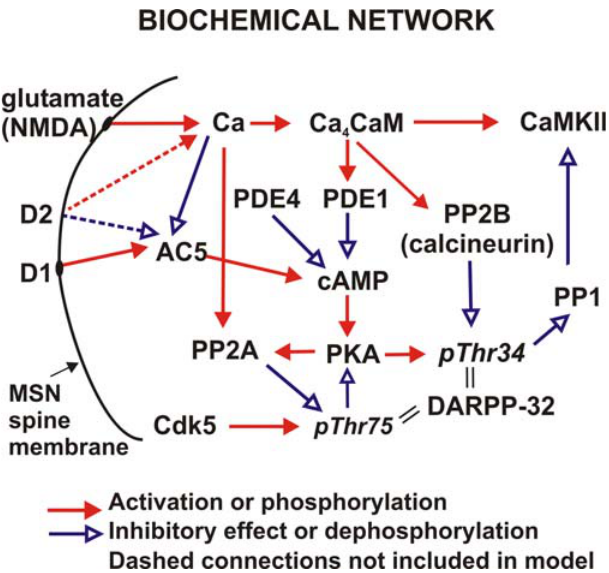
Figure 1. Second Messenger Pathways Involved in the Phosphorylation of DARPP-32 on Thr34 and Thr75 in Medium Spiny Projection Neurons A calcium elevation produced by glutamate leads to calcium binding to CaM (Ca 4 CaM), which activates both CaMKII and PP2B, the latter dephosphorylating DARPP-32 on Thr34. Stimulation of the dopamine D 1 receptor activates the PKA cascade via AC5 and cAMP formation. PKA in its turn increases phosphorylation of DARPP-32 on Thr34, which then inhibits PP1. DOI: